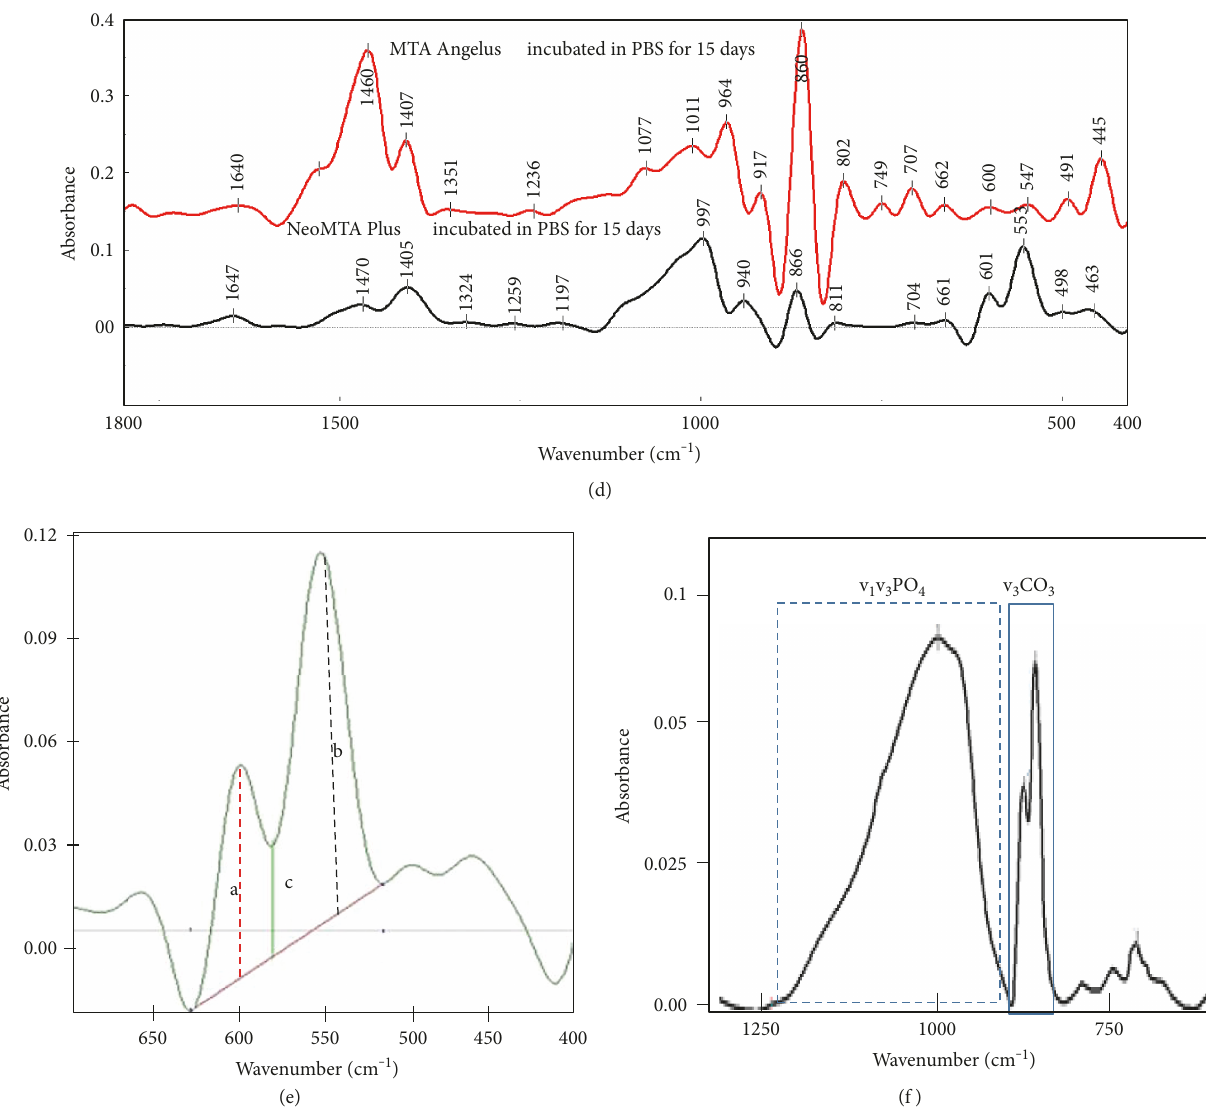
Figure 1: FTIR spectra of (a) original components of MTA Angelus and NeoMTA Plus; completely versus initially set MTA Angelus (b) and NeoMTA Plus (c); deconvoluted spectra of completely set materials that were incubated for 15 days in PBS (d). Crystallinity was calculated by (a+ b)/c (e). CO /PO ratio was calculated by dividing the area under v 3 4